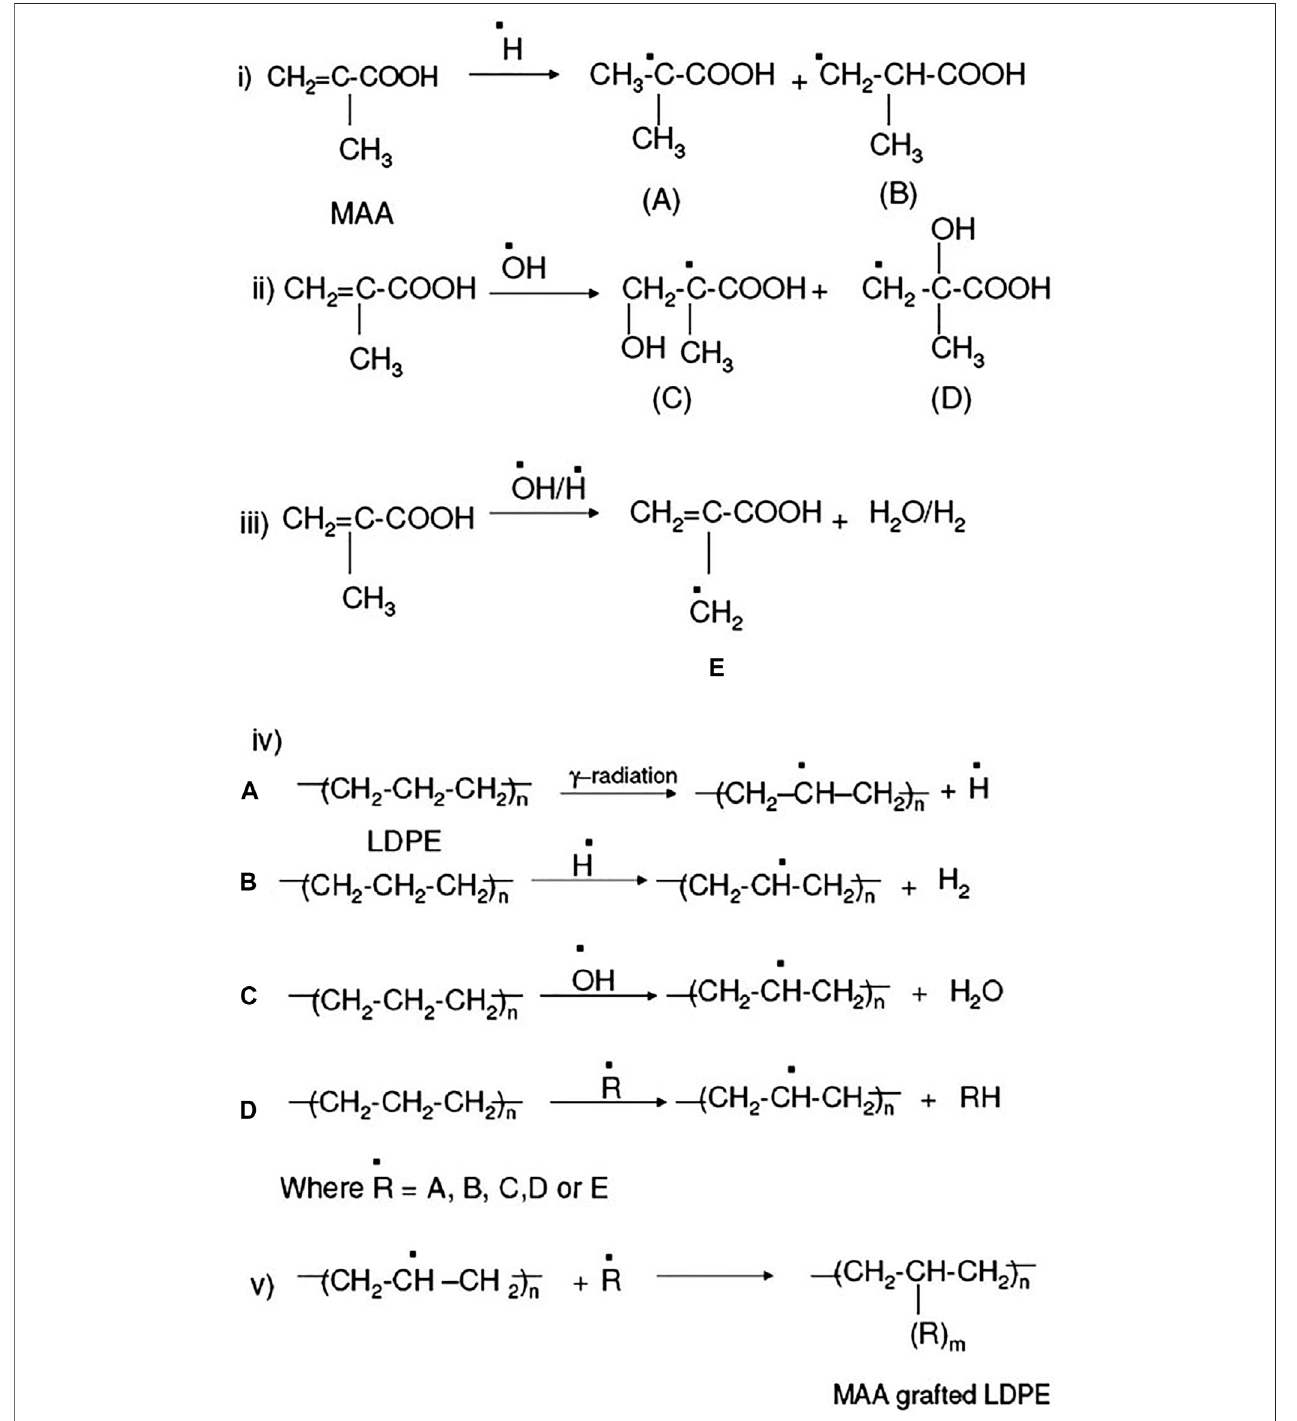
FIGURE 3 | Gamma radiation induced grafting on low density polyethylene (LDPE) (Chowdhury and Sabharwal, 2011).